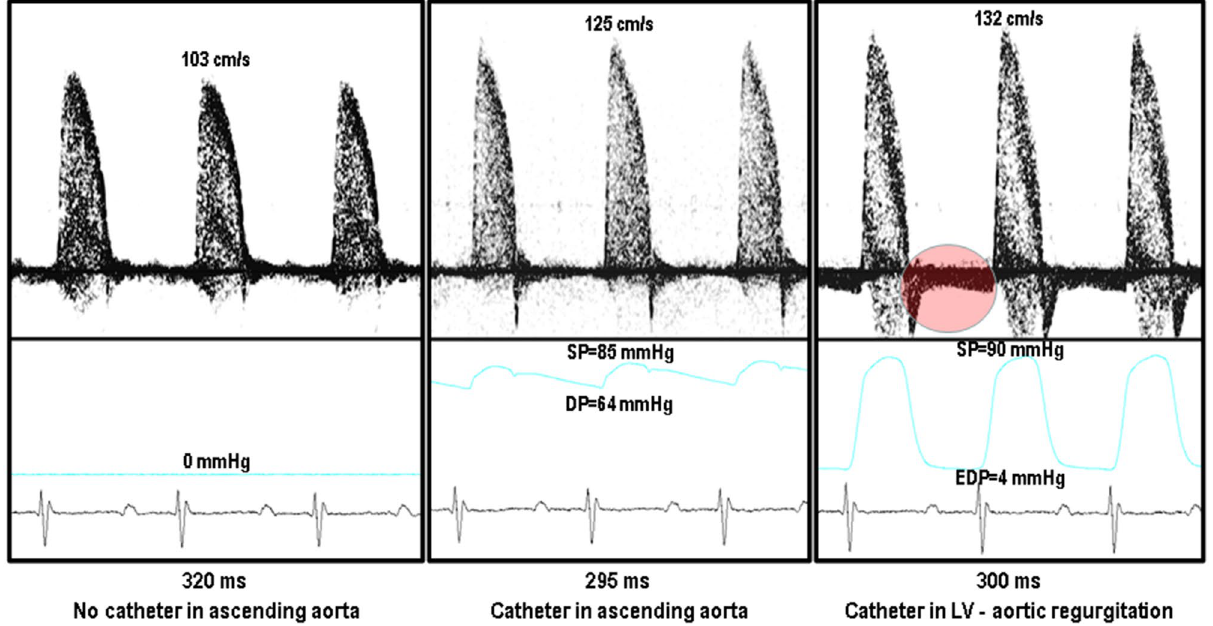
Figure 8. Ascending aortic flow velocity at ( A ) no intravascular pressure catheter, ( B ) intravascular pressure catheter in the ascending aorta, and ( C ) intravascular pressure catheter in the left ventricle via aortic valves (presence of aortic regurgitation—see